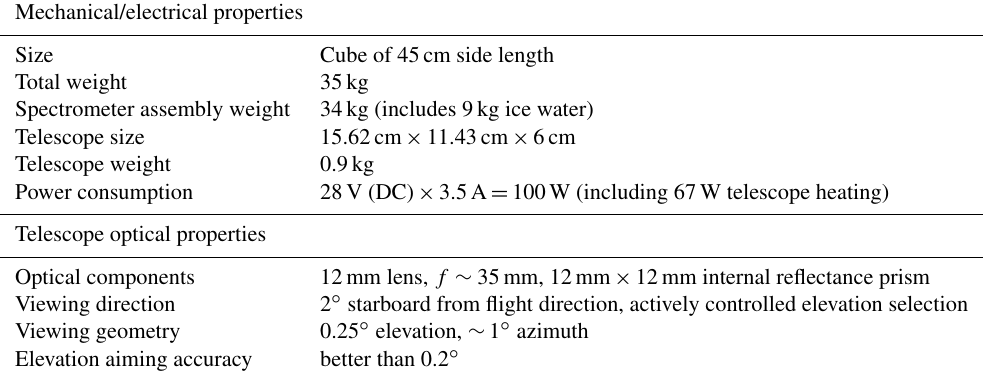
Table 1. Instrument characteristics.